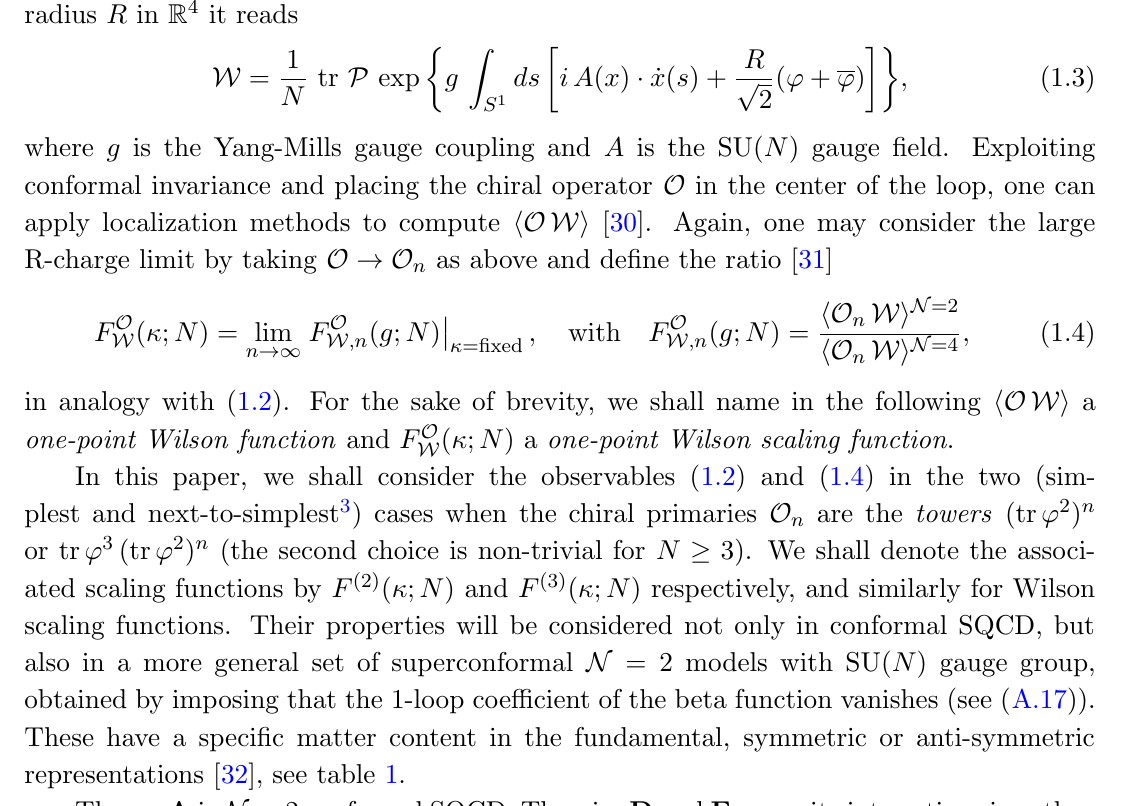
Table 1 . The (cid:12)ve families of = 2 superconformal theories with SU( N ) gauge group and matter N in fundamental (F), symmetric (S) and anti-symmetric representations (A), cf. [32]. radius R in R 4 it